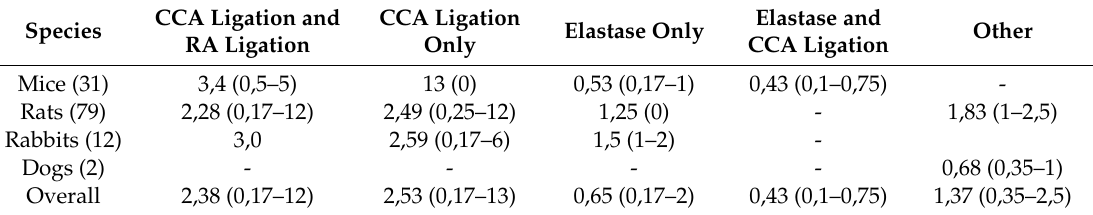
Table 3. Mean time of aneurysm formation in months